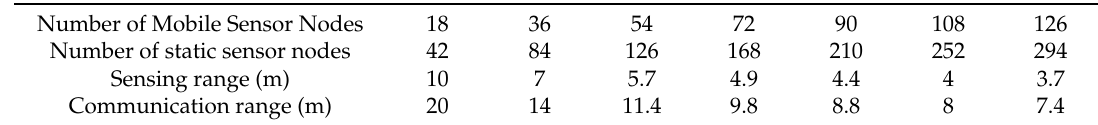
Table 1. The parameters of different hybrid